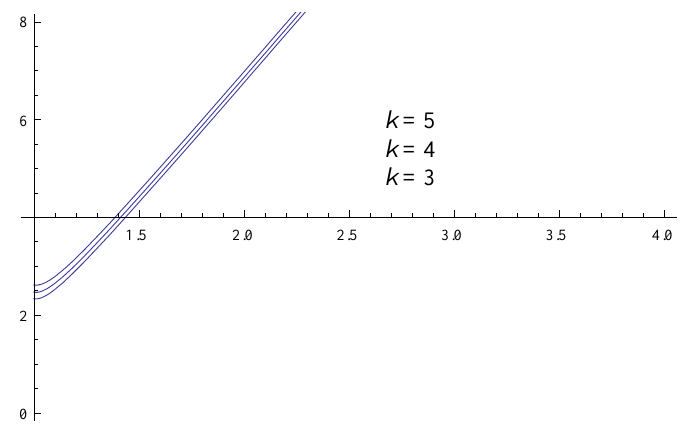
Figure 2. The impact of parameter k on the MRL of the constrained ( k , d )-out-of- n : F system.